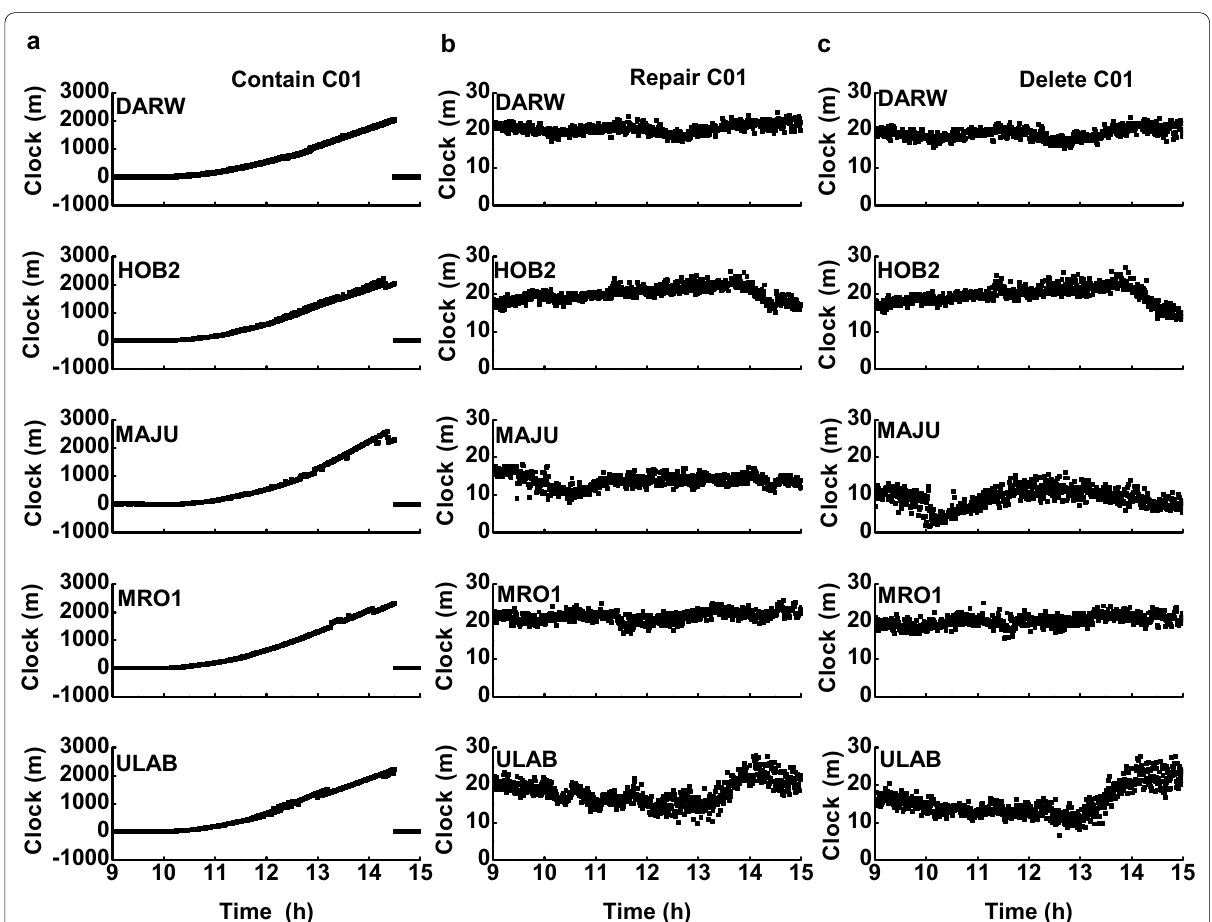
Fig. 6 Comparison of biases for the estimated receiver clock error with the data from the maneuvering satellite included a , and with the orbital error of the maneuvering satellite corrected b , and with the data from the maneuvering satellite deleted c . From top to bottom, the plots are for stations DARW, HOB2, MAJU, MRO1, and ULAB